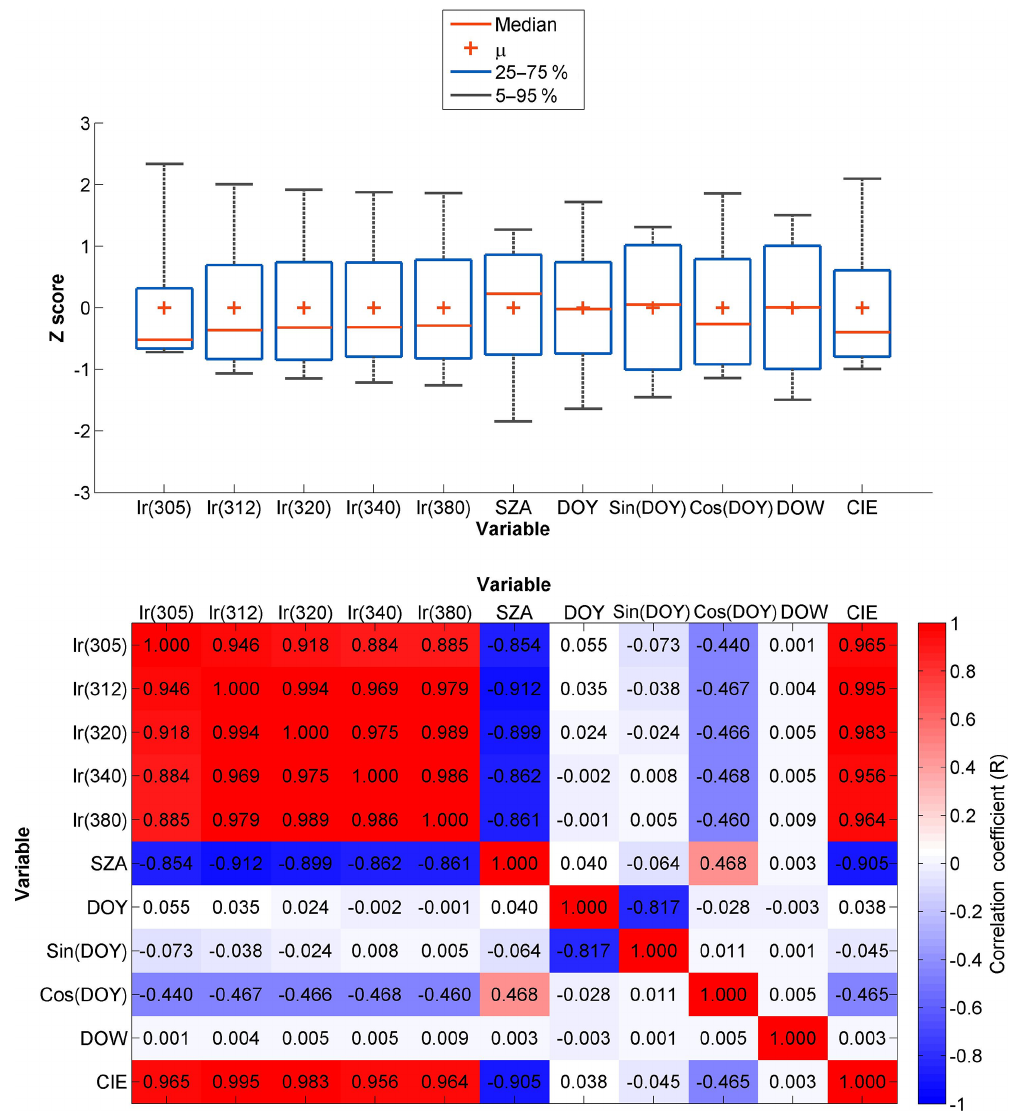
Figure 2. Model selection. Top: boxplots of the z scores of the input variables and the erythemal UV dose (CIE) with mean values denoted by µ . Bottom: the pairwise linear Pearson correlation coefficient for each combination of the input variables and/or the output variable. The results are unnoticeably different in the case of vitamin D and DNA-damage doses. To save space, we have used abbreviated labeling of the sinusoidal terms so that, for example, sin(DOY) refers explicitly to sin ( DOY × 2 π/T ) .